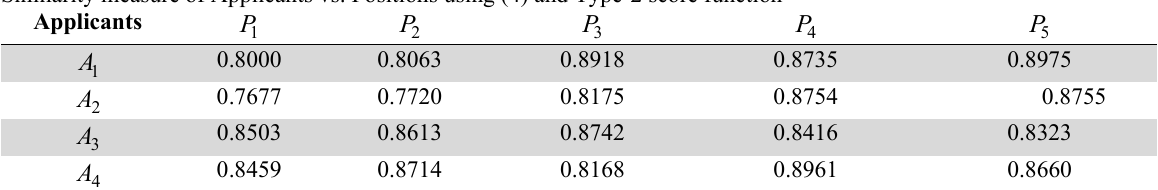
Similarity measure of Applicants vs. Positions using (4) and Type-2 score function